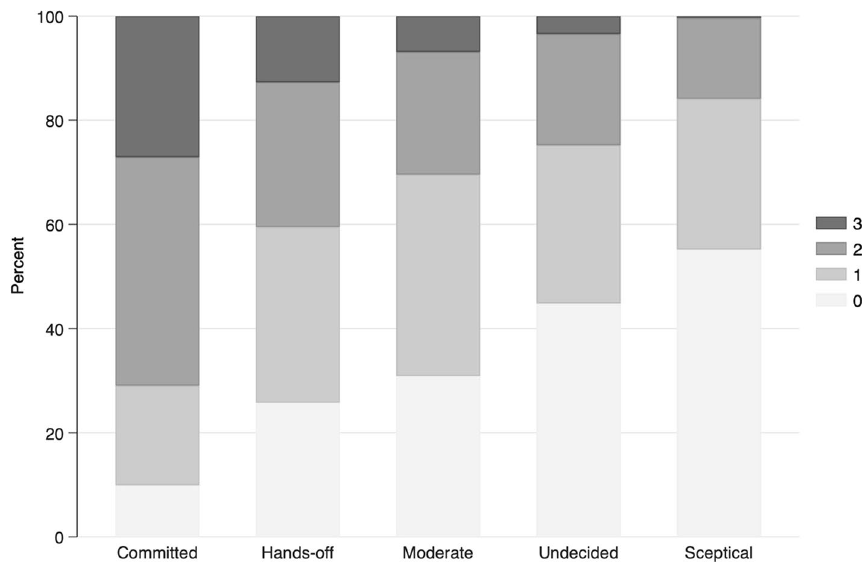
Fig. 2 Intensity of support for refugees (number of activities) and attitudes towards diversity. Note: All quantities are weighted for survey design and